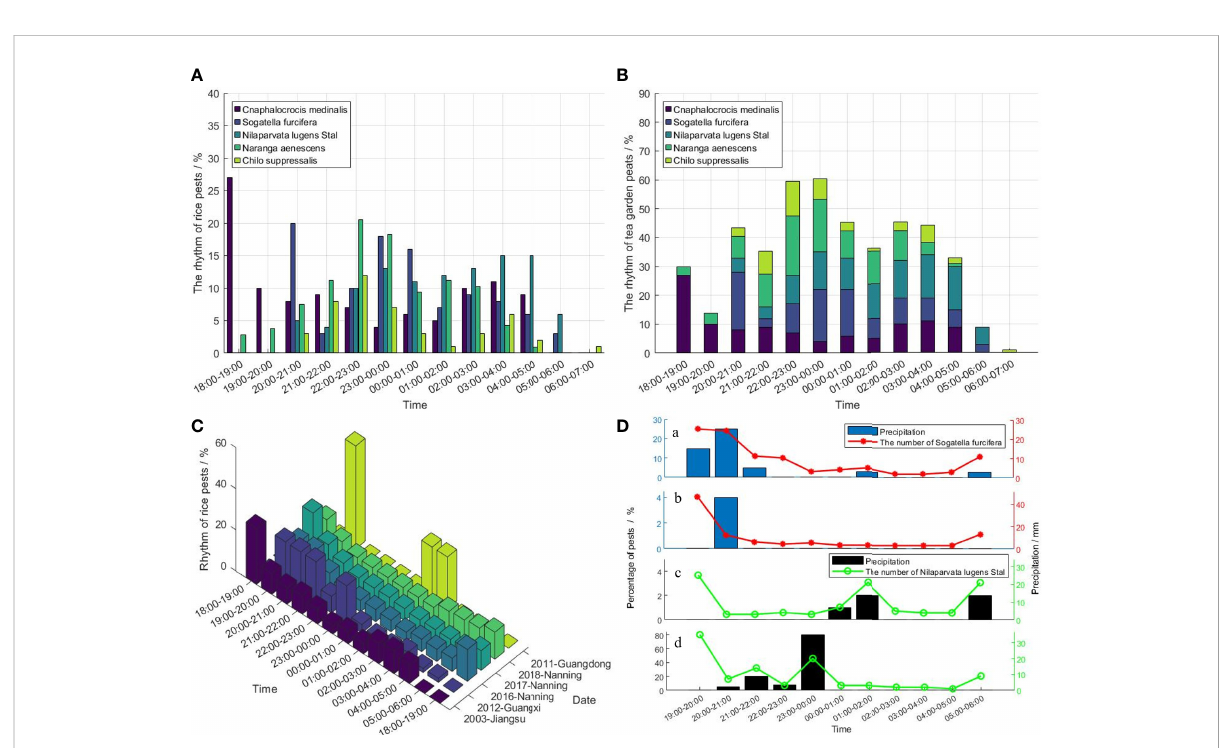
FIGURE 5 The phototactic rhythm of rice pests. (A) The phototactic rhythm of Cnaphalocrocis Medinalis, Sogatella Furcifera, Nilaparvata Lugens Stal, Naranga Aenescens, Chilo Suppressalis in rice crops, (B) The bar chart of Rhythm for Cnaphalocrocis Medinalis, Sogatella Furcifera, Nilaparvata Lugens Stal, Naranga Aenescens, Chilo Suppressalis in rice crops, (C) The phototactic rhythm of Cnaphalocrocis Medinalis in different regions and years, (D) The effects of Precipitation on rice pests, (a) The effect of precipitation on Sogatella Furcifera on June 15, (b) The effect of precipitation on Sogatella Furcifera on June 16, (c) The effect of precipitation on Nilaparvata Lugens Stal on June 24, (d) The effect of precipitation on Nilaparvata Lugens Stal on June 28 (Yang,